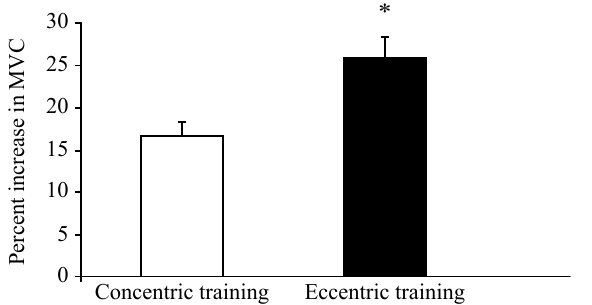
Figure 1 – Percent increase in maximal voluntary contraction (MVC) of the contralateral untrained quadriceps muscle (mean ± SE, s, n = 15) after 12 weeks resistance training. Percent increase in MVC after eccentric training is significantly larger than concentric training. *p ≤ 0.05.